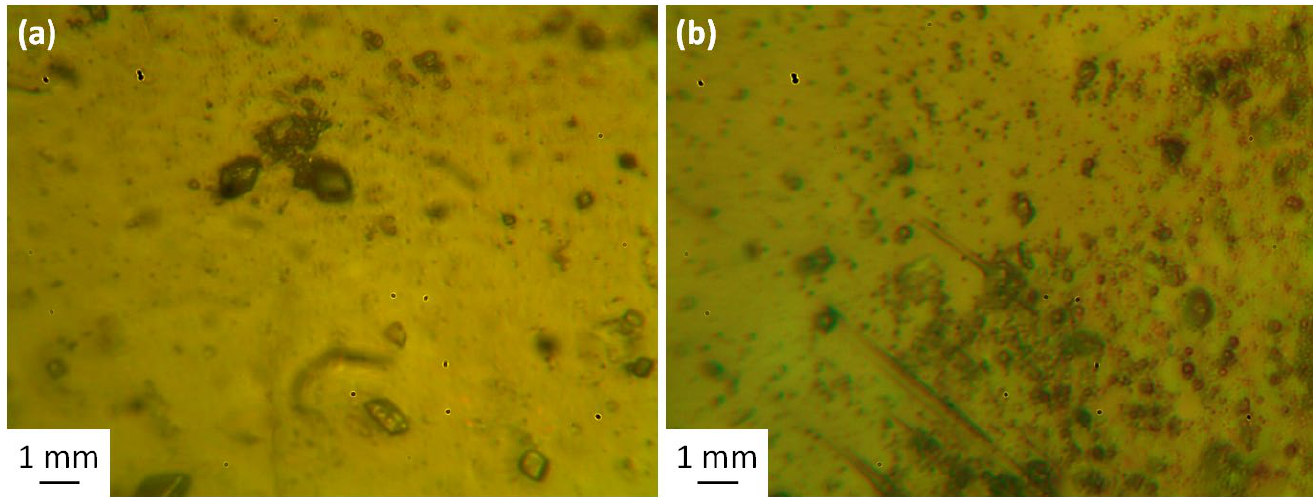
Figure 6. Optical microscopic images of PVC (blank) film: ( a ) before irradiation and ( b ) after irradiation.